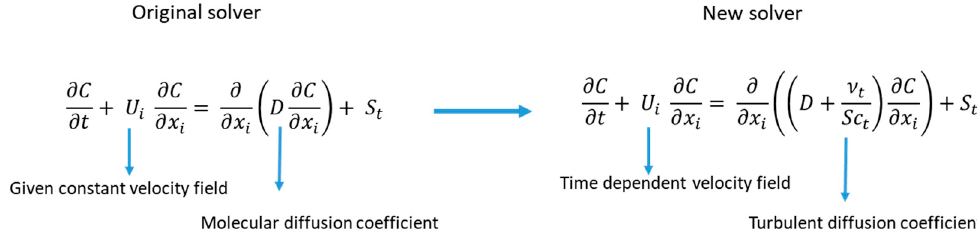
Figure 1. A comparison between the original and customized solvers.